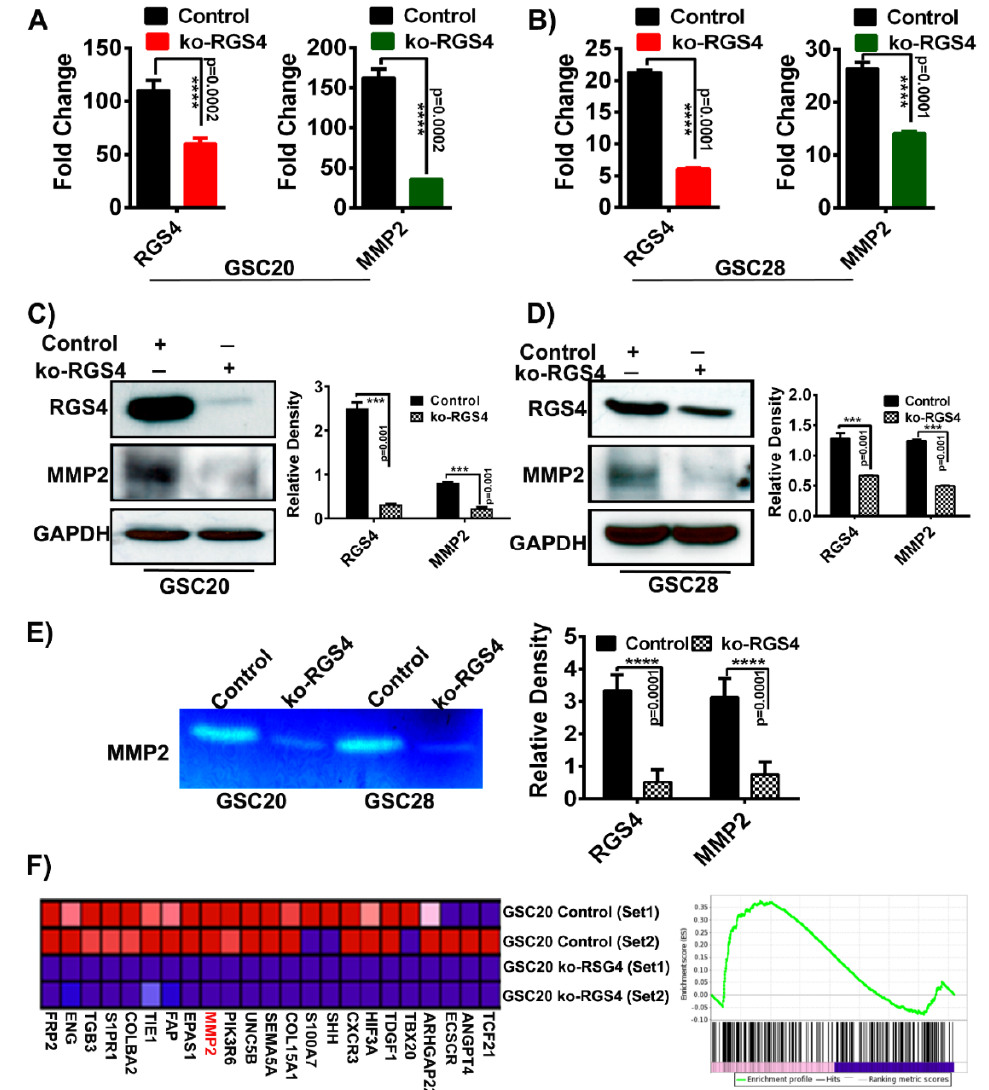
Figure 4. RGS4 modulate matrix metalloproteinase-2 (MMP2) expression. RT-PCR and immunoblot analysis of RGS4 and MMP2 in GSC20 and GSC28 cells treated with knockout-RGS4 (ko-RGS4) and untreated control cells ( A – D ) ( n = 3) (**** p = 0.0002; **** p = 0.0001; *** p = 0.001). GAPDH was used as a loading control. The density levels were quantified and represented as a bar graph. ( E ) MMP2 activity was evaluated by gelatin zymography by using conditioned media from control and ko-RGS4-transfected GSC20 and GSC28 cells collected 48 h after transfection. Bar graph represents the densitometry analysis of MMP2 activity. ( F ) Gene set enrichment analysis (GSEA) using gene set involved in maintaining GSC angiogenesis after ko-RGS4 treatment. The green line demonstrate the enrichment profile. The error bars are plotted based on the SEM (standard error of mean).